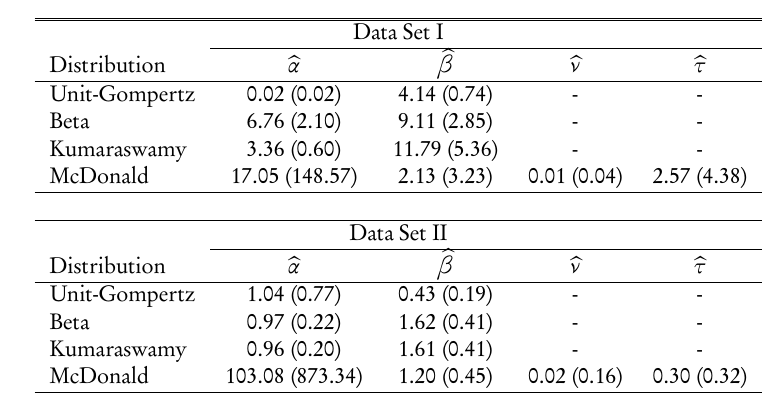
Maximum likelihood estimates (standard-error).